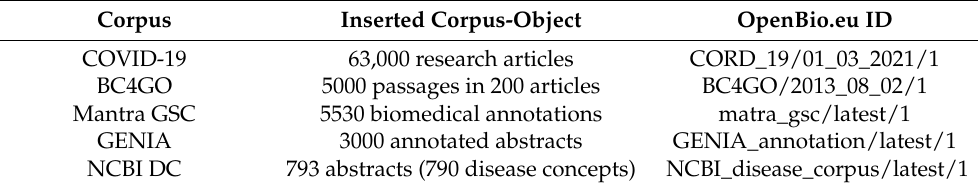
Table 2. Corpora imported into OpenBio.eu (with unique OpenBio.eu IDs).